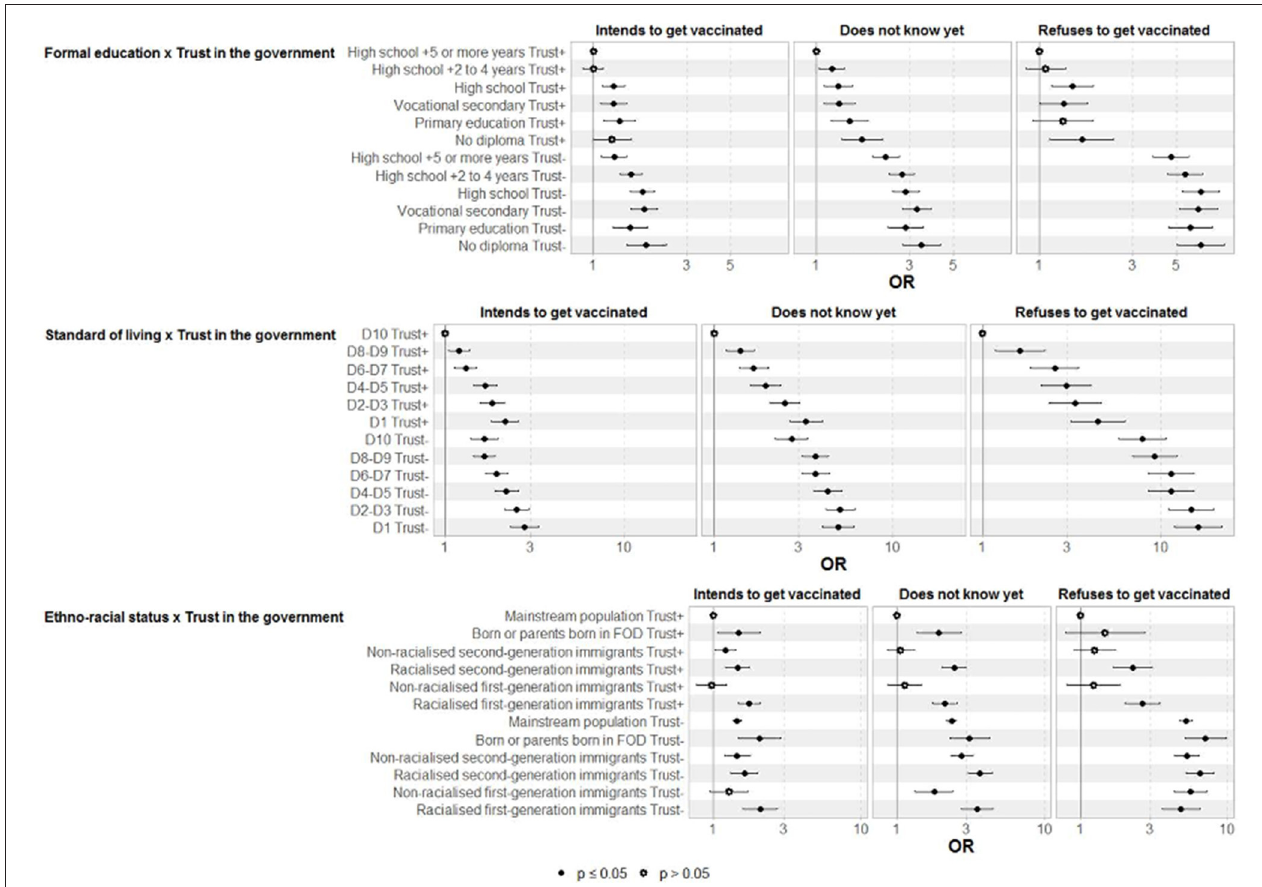
FIGURE 2 | Interaction between trust in the government (yes or no) and (i) diploma, (ii) standard of living and (iii) ethno racial status and vaccination status. Multinomial regression (ref = being vaccinated). EpiCov study, 3rd wave, July